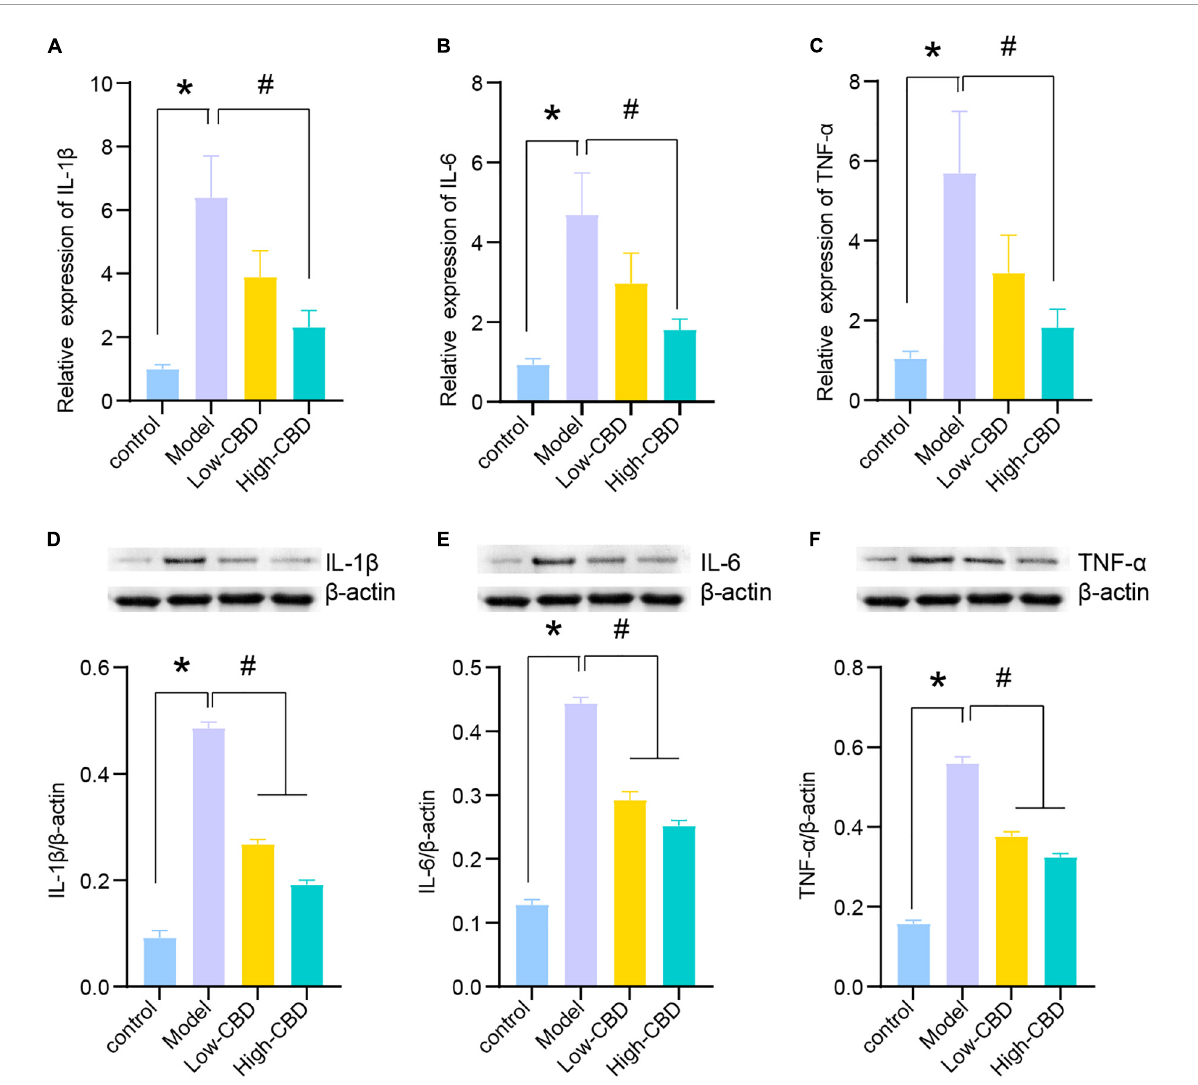
FIGURE3 Effects of cannabidiol (CBD) on the expression of IL-1 β , IL-6, and TNF- α in the temporal lobe cortex of epileptic rats. (A-C) IL-1 β , IL-6, and TNF- α were detected by qRT-PCR. (D-F) IL-1 β , IL-6, and TNF- α were detected by western blotting (WB). *Represents significant comparison with the control group, #represents significant comparison with the Model group, P <